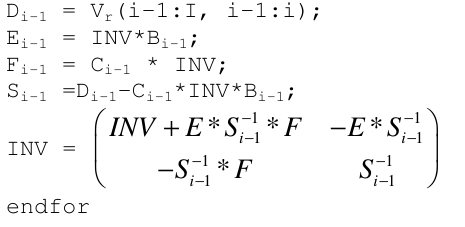
Algorithmic Complexity : The iterative